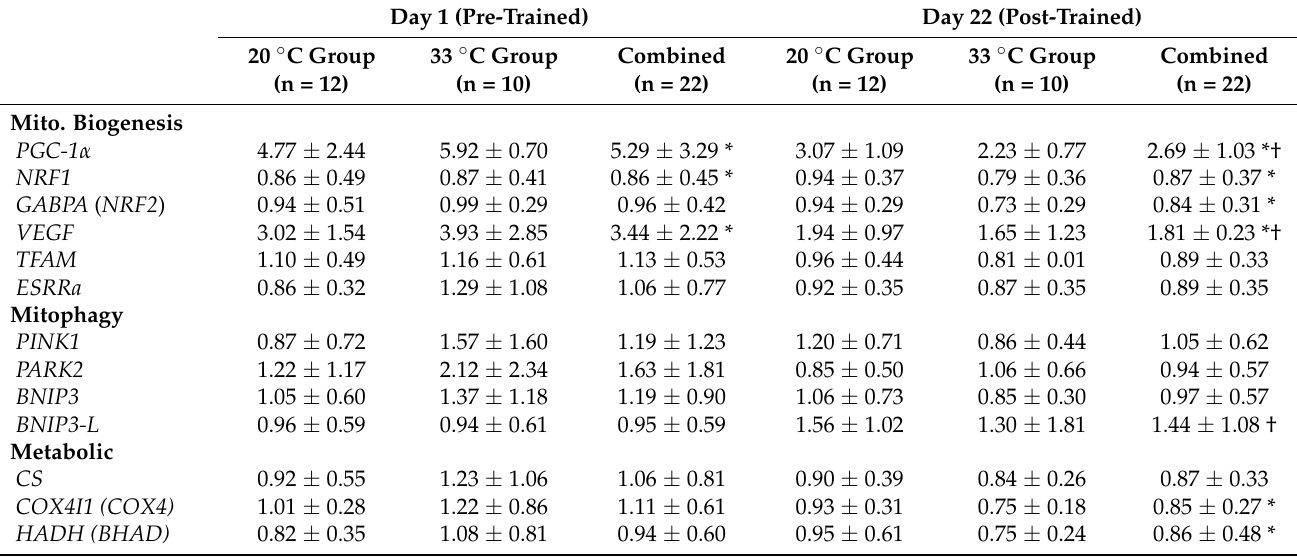
Table 4. Acute and Chronic Relative Gene Expression on Day 1 and Day 22. Day 1